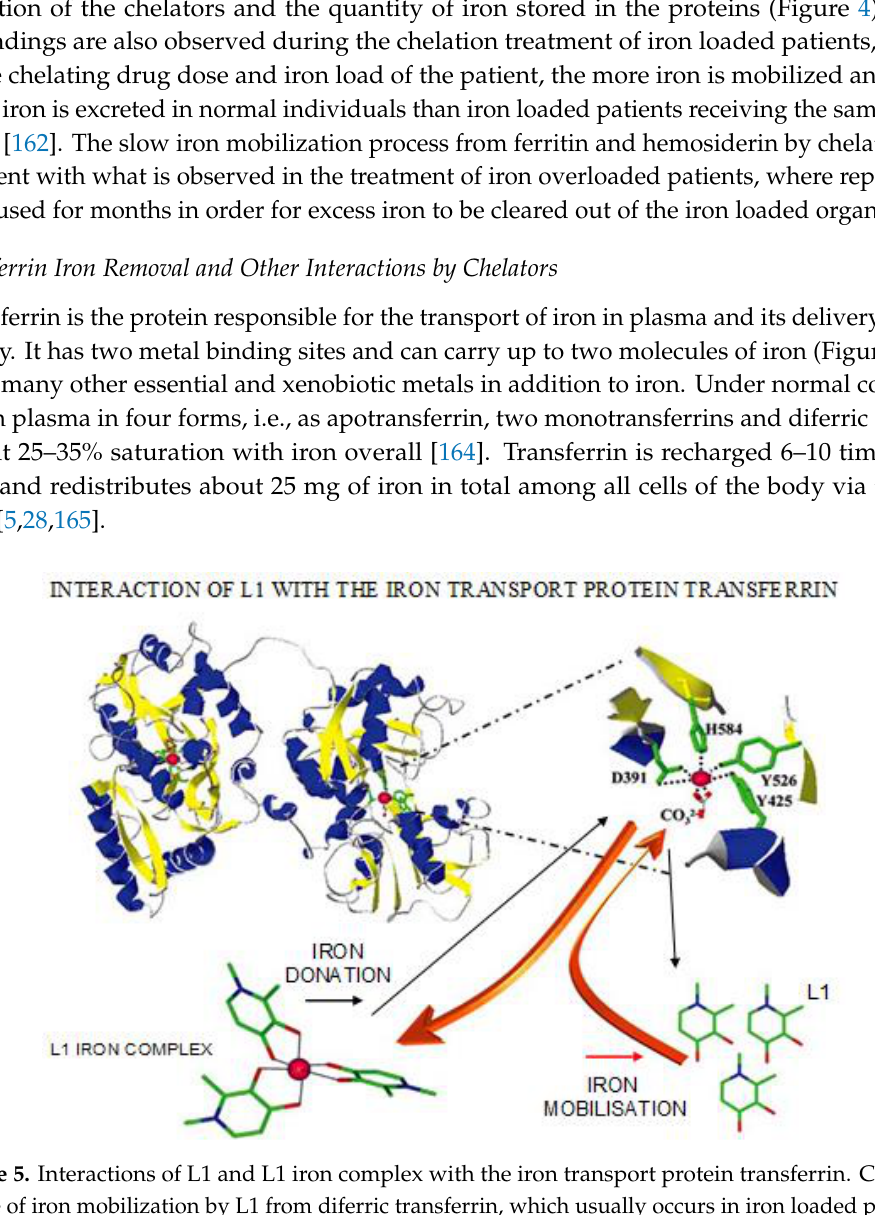
Figure 4. Iron mobilization from ferritin and hemosiderin by deferiprone (L1). Cartoon image of iron